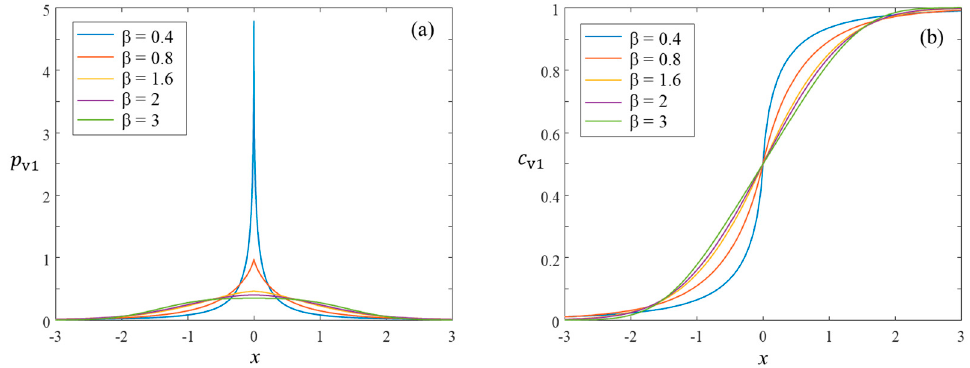
Figure 2. ( a ) Probability and ( b ) cumulative distributions for GNDv1 with zero mean and unit standard deviation.